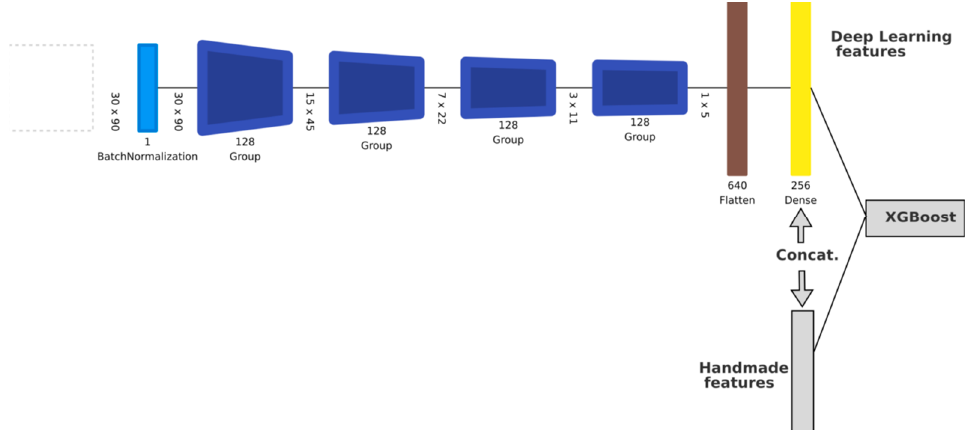
Figure 2. Wide and Deep Ensemble Model.